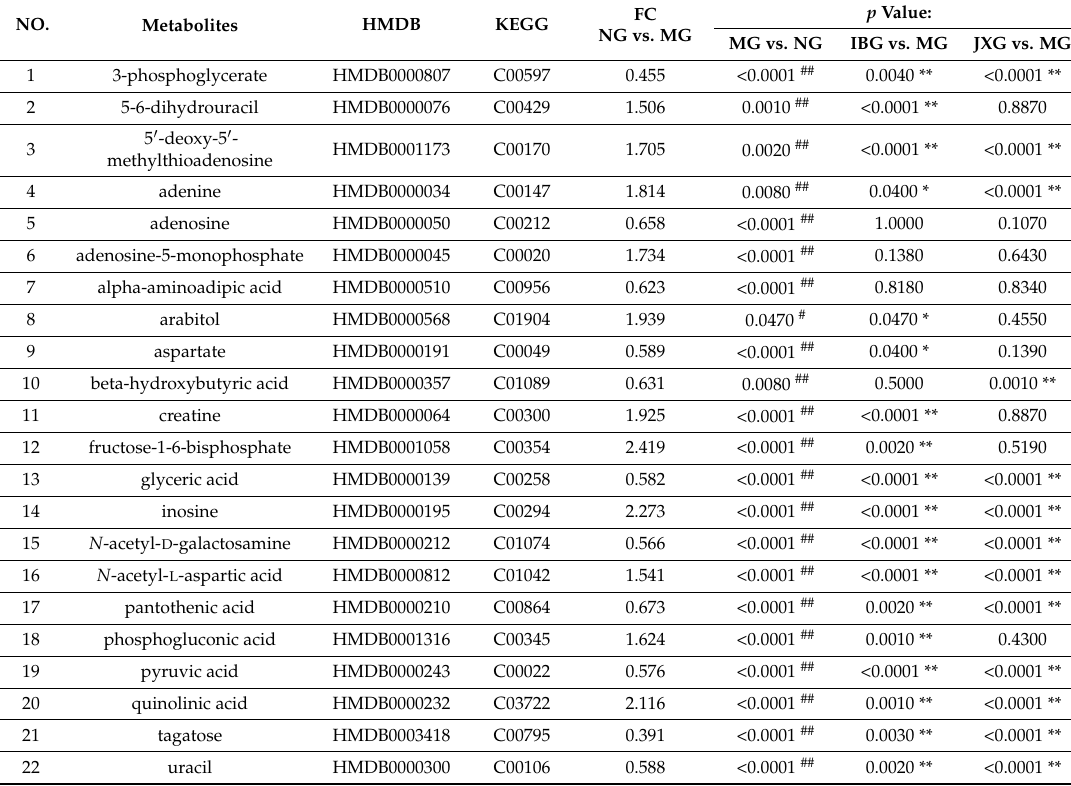
Table 1. Potential biomarkers of